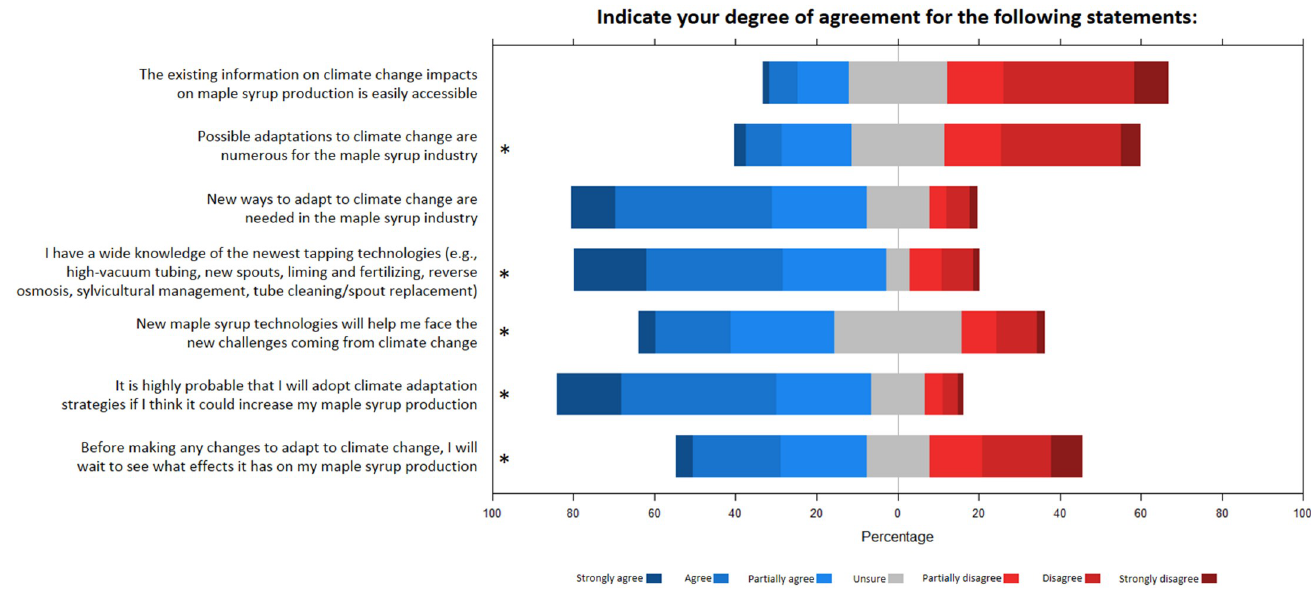
Fig 8. General statements on adaptation to climate change for maple syrup production. Responses of the survey participants for statements about adaptation to climate change for maple syrup production. Statements followed by a � symbol indicate a significant effect of at least one predictor (see Table 3 and S3 File).